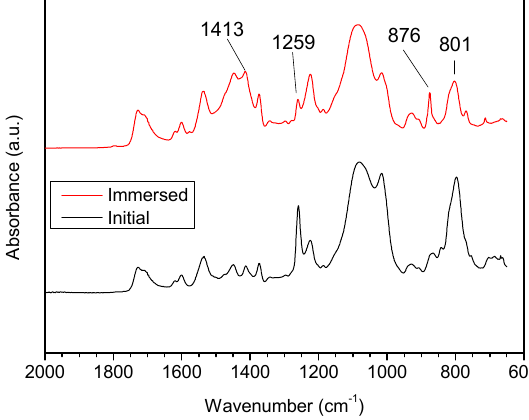
Figure 10. FTIR spectra of PU-Si4 before and after immersion in seawater.